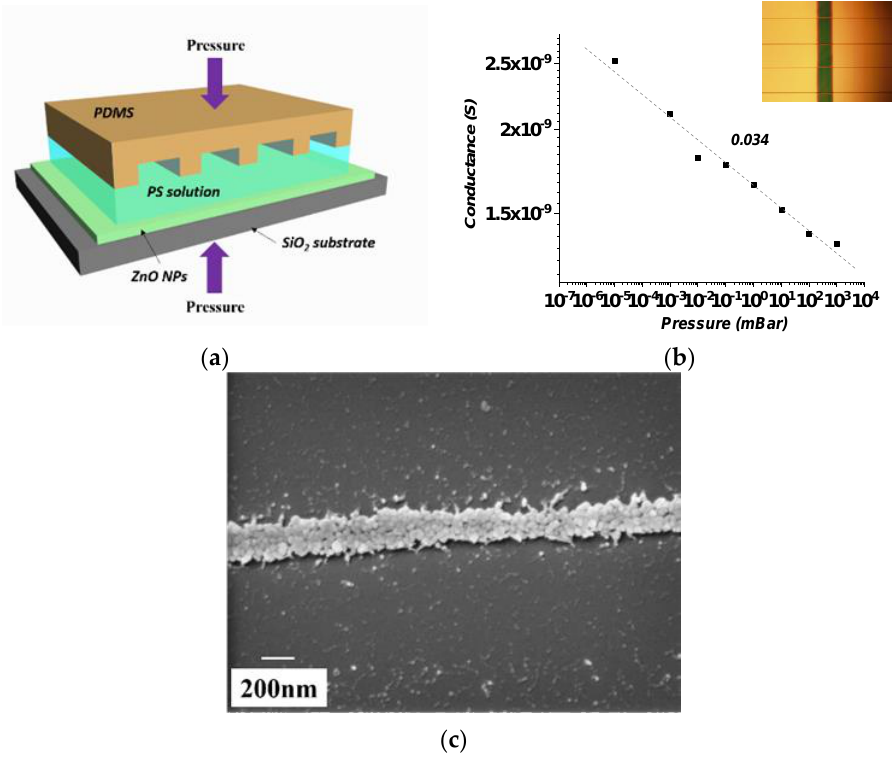
Figure 6. ( a ) Illustration of mould-guided drying technique. ( b ) The sensing of oxygen partial pressure in air with patterned ZnO NP lines. ( c ) ZnO NP lines with less than 200 nm in width.